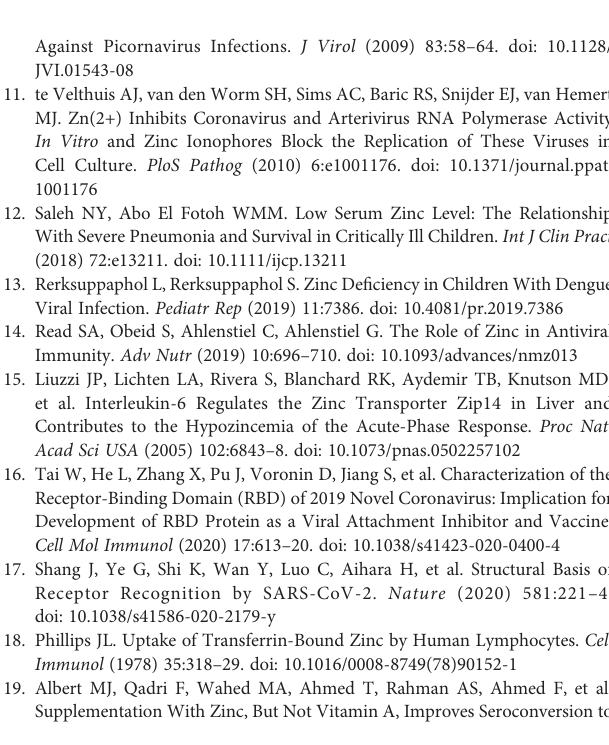
Supplementary Figure 1 | Correlations between serum zinc ion concentrations andlevels ofantibodiesagainstSARS-CoV-2 proteins.Correlationsbetween serum zinc ion levels and anti-SARS-CoV-2 NP (A, D) , RBD (B, E) , S1+S2 protein (C, F) IgA, IgM and IgG, IgG1, IgG2, IgG3, IgG4 levels as well as neutralizing antibody (G) are shown. Samples were collected in the acute phase (day 7-21) (n=23) and the latephase(afterday21)(n=27)fromCOVID-19patients.TheSpearman ’ srank-sum correlation coef fi cient and signi fi cance are